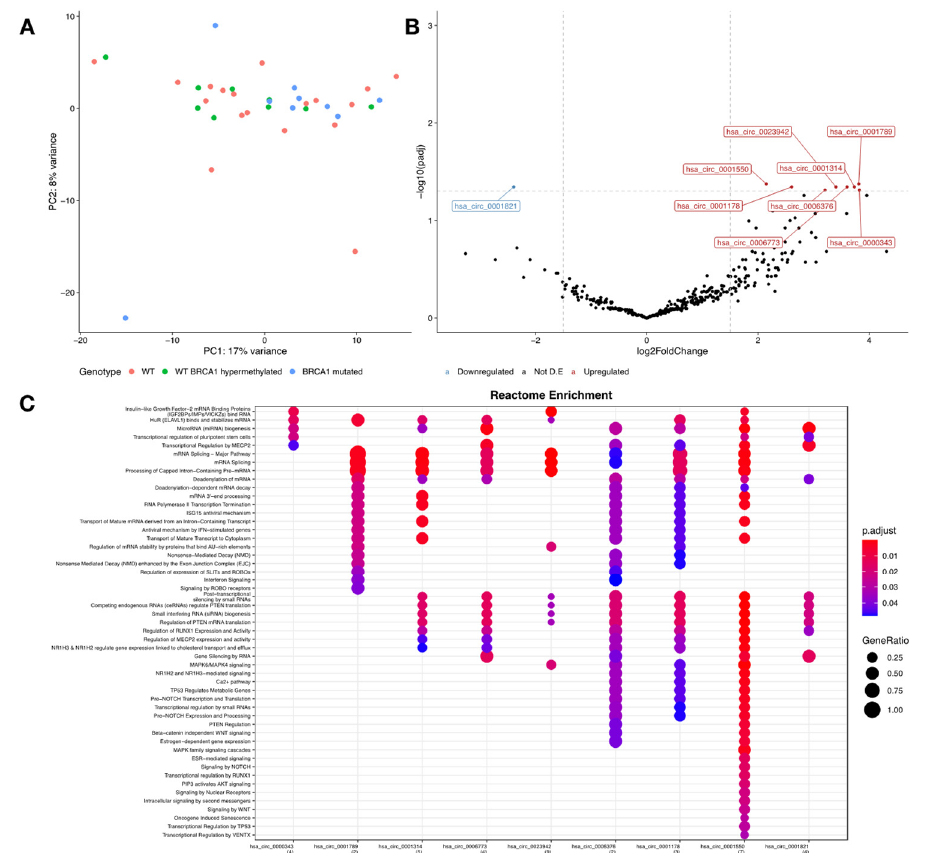
Figure 4. CircRNA transcriptomic profile according to mutational data of TNBC patients. ( A ) Principal component analysis showing overall similarity in expression data between Wildtype, Wildtype with BRCA1 hypermethylated, and BRCA1 mutated patients; ( B ) differential expression analysis showed significant results when comparing Wildtype and BRCA1 mutated patients, in which it was possible to observe nine differentially expressed circRNAs, being one downregulated (hsa_circ_0001821) and eight upregulated (hsa_circ_0001550, circ_0001178, circ_0006376, circ_0023942, circ_0001314, circ_0001789, and circ_0000343); ( C ) Reactome enrichment of the RBPs predicted to interact with these circRNAs revealed similar pathways to the ones enriched in the TNBC vs. adjacent tissue